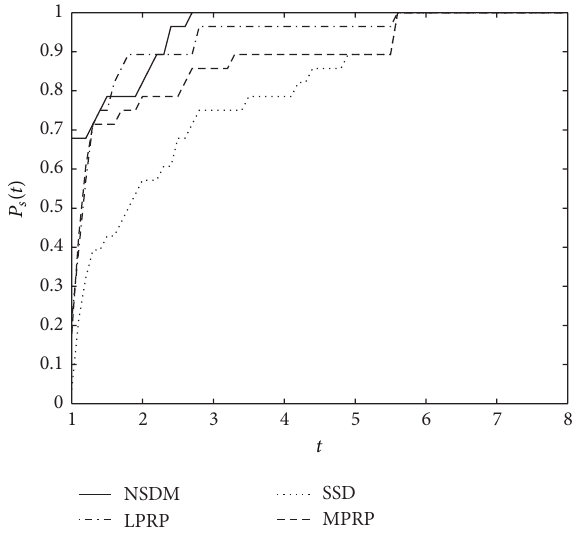
Figure 3: Performance profiles about the number of gradient eval- uations.